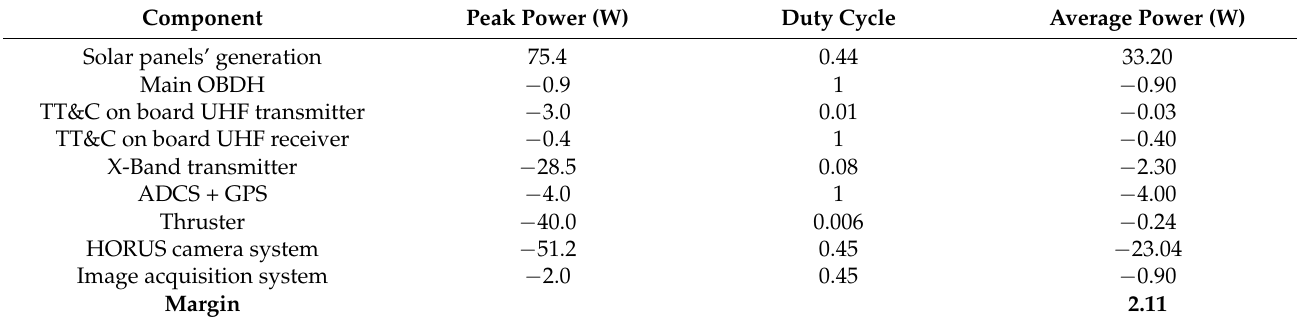
Table 11. Power budget for average daily power